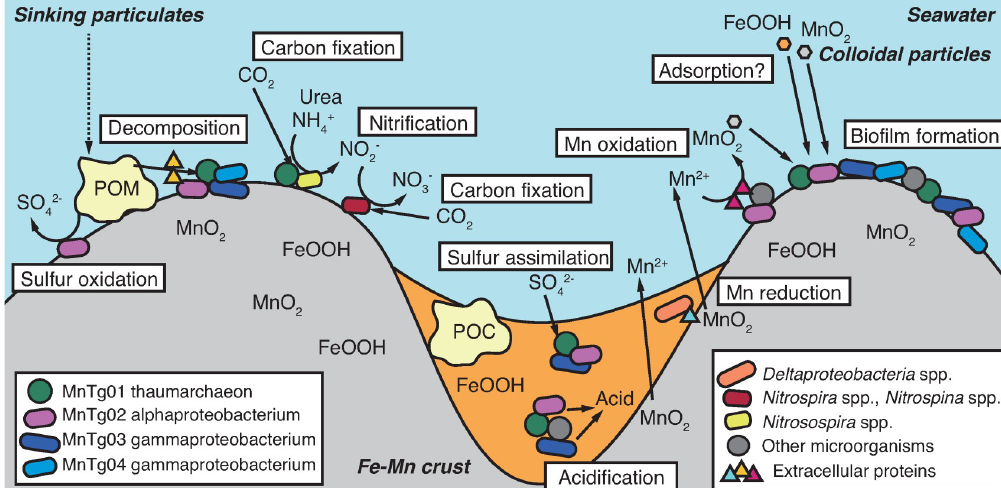
Fig 7. Proposed model of the microbial contribution to the biogeochemical cycling of C, N, S, Fe, and Mn and the formation of the Fe-Mn crust. Illustration of a side-view of the crust at micrometer-scale is shown. Microorganisms with nano-sized fibers form biofilms in the crusts [13]. The biofilm can adsorb Fe and Mn oxide particles in seawater. Extracellular proteins produced by the microorganisms contribute to decomposition of particulate organic matter (POM) and manganese oxidation/reduction. Nitrifers play a role as primary producers in the crust ecosystem. Acidification by fermenters and ammonia oxidizers cause dissolution of Mn and Fe oxides. See main text for details.